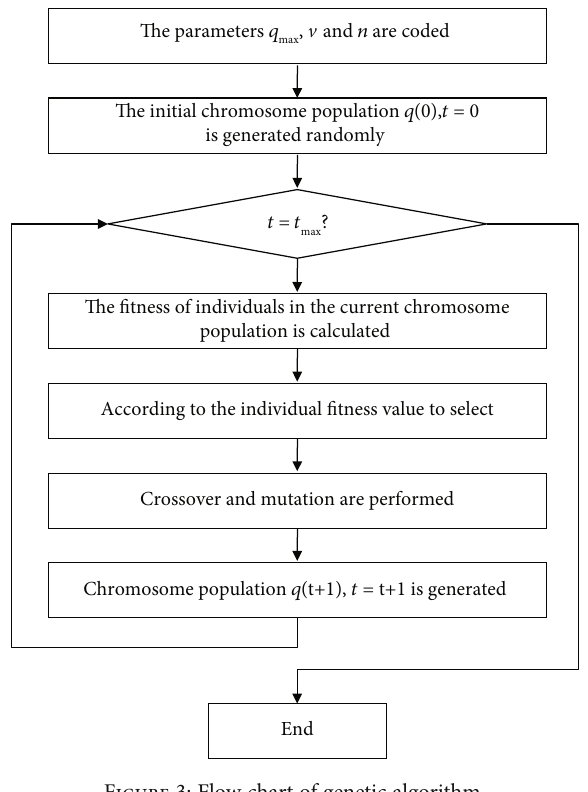
Figure 3: Flow chart of genetic